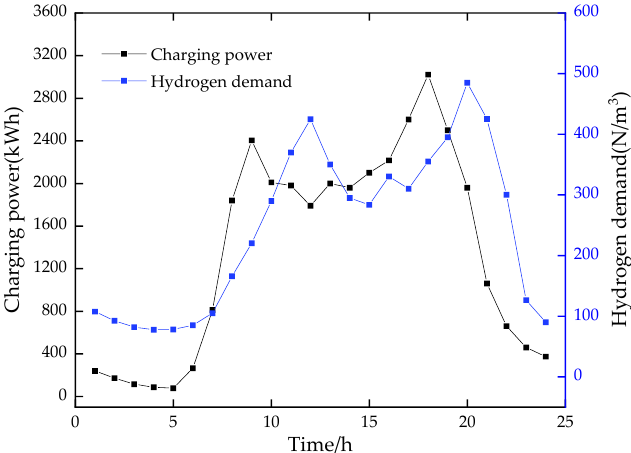
Figure 6. EV charging power demand and HFCV hydrogenation demand curve.